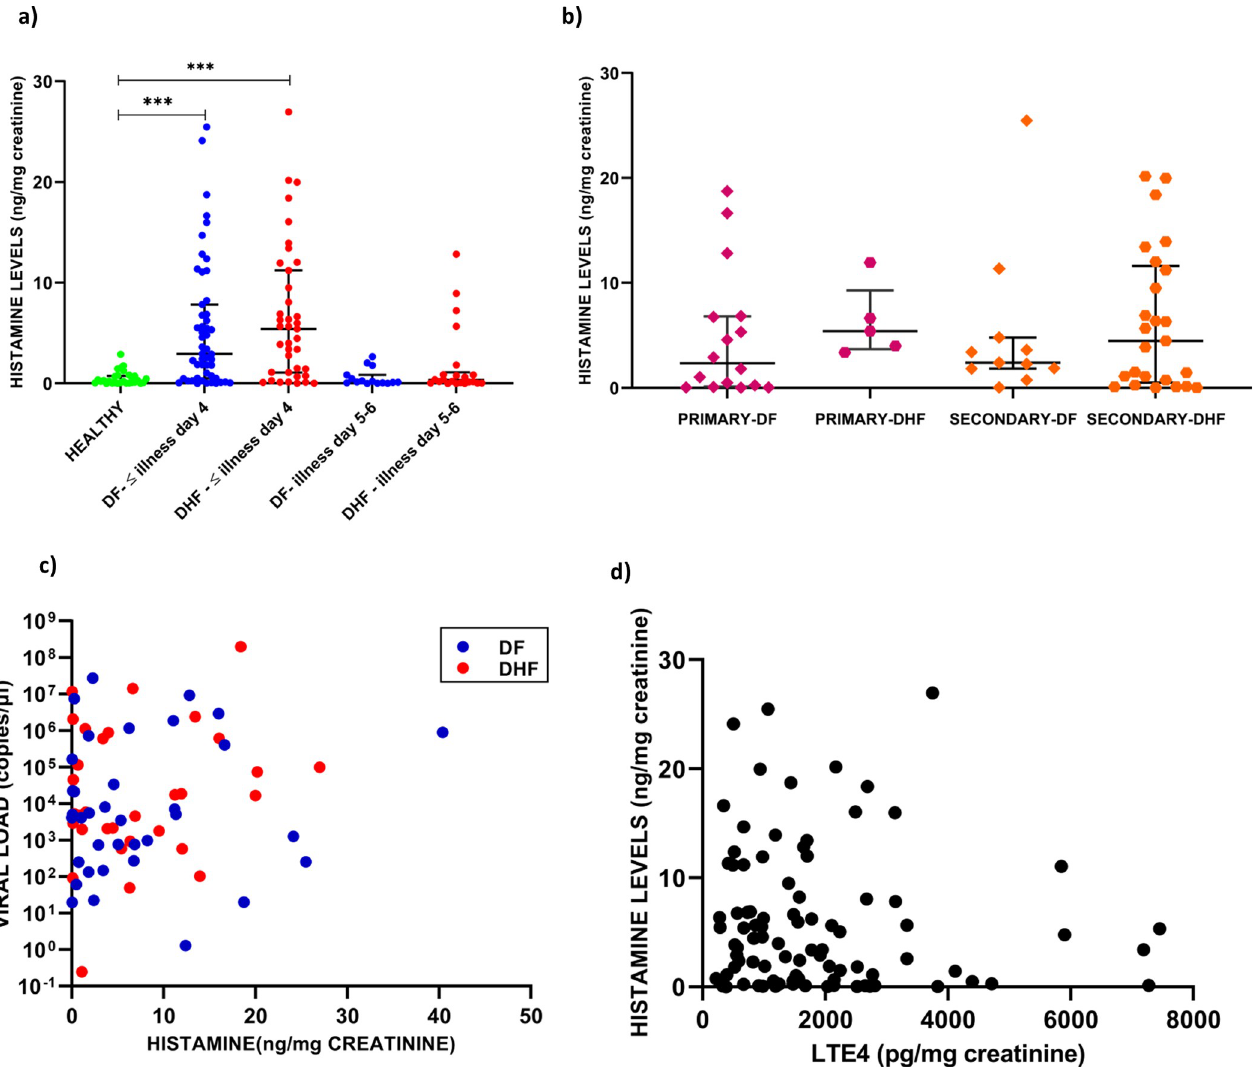
Fig 6. Urinary histamine levels in acute dengue infection. Urinary histamine levels were measured by quantitative ELISA, in healthy individuals (n = 29), in those with DF (n = 52) and those who progressed to develop DHF (n = 39) with < 4 days of illness and in patients with DF (n = 15) and DHF (n = 25) in 5 to 7 th day of illness (a). The histamine levels were compared patients with DF (n = 17) or DHF (n = 05) due to primary infection or DF (n = 11) or DHF (n = 25) due to secondary infection (b), were correlated with urinary LTE4 levels (c), correlated with the viral loads (d)The p values were calculated by the Mann-Whitney test and the correlations carried out by the Spearmans correlation. Error bars represent the median and IQR. ��� P <